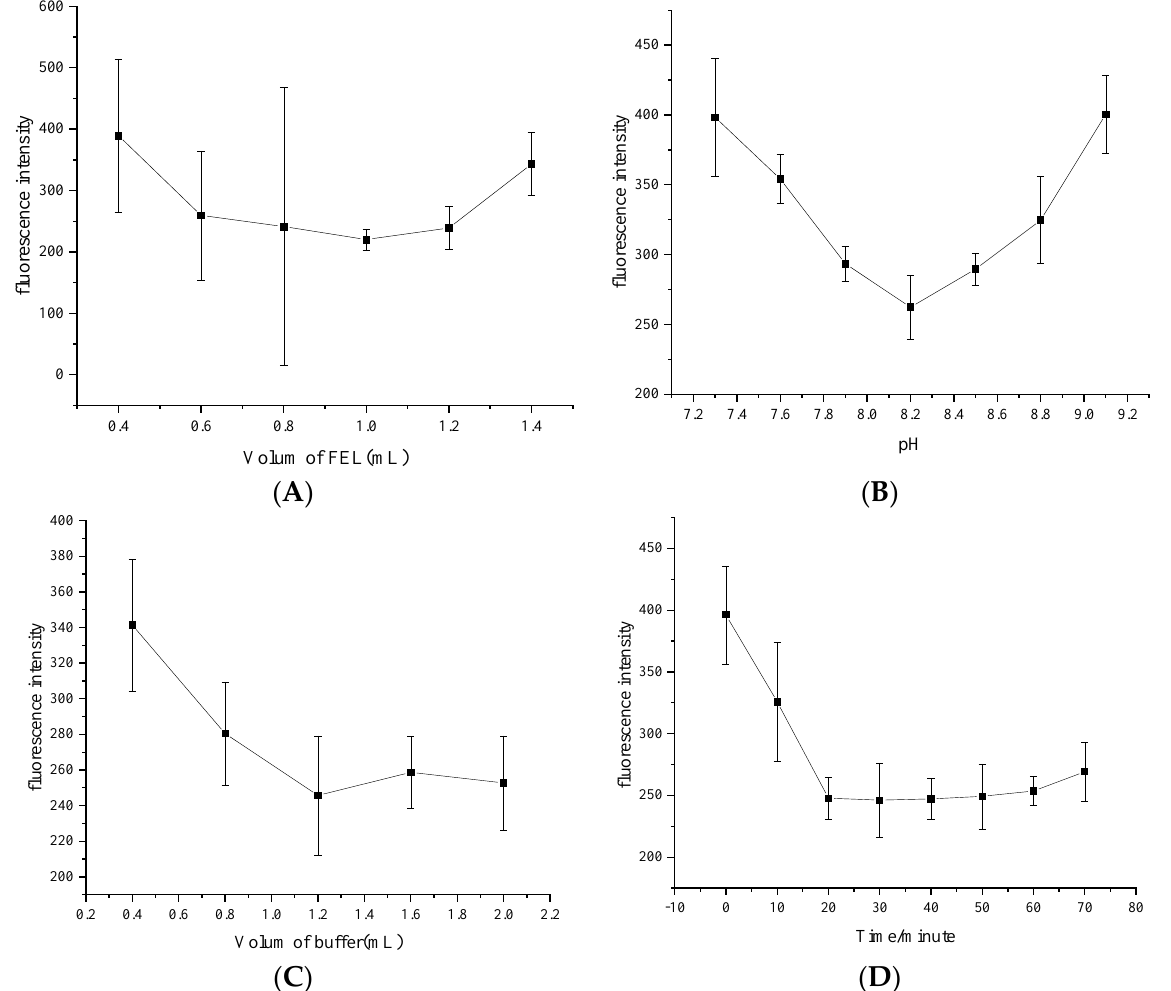
Figure 4. Effects of ( A ) FEL dosage; ( B ) pH of the buffer solution; ( C ) amount of buffer solution; and ( D ) reaction time. FEL cannot stably exist in strong acid and alkali environments, and it is easier to decompose in strong acid environments. Therefore, this experiment used the weakly alkaline buffer Tris-HCl to investigate the quenching degree of the fluorescence intensity of the system when the pH value of the buffer was 7.3, 7.6, 7.9, 8.2, 8.5, 8.8 and 9.1. As shown in Figure 4B, the fluorescence quenching degree (262.335 ± 0.0375, n = 3) is the strongest when the pH is 8.2, so the optimal pH value of Tris-HCl buffer is 8.2. The carboxyl oxygen atoms and Cd atoms in GA on the surface of quantum dots can cooperate twice to form a ring substance, which enhances the fluorescence performance of the system (Figure 5). In addition, pH can affect the structure of the substance.